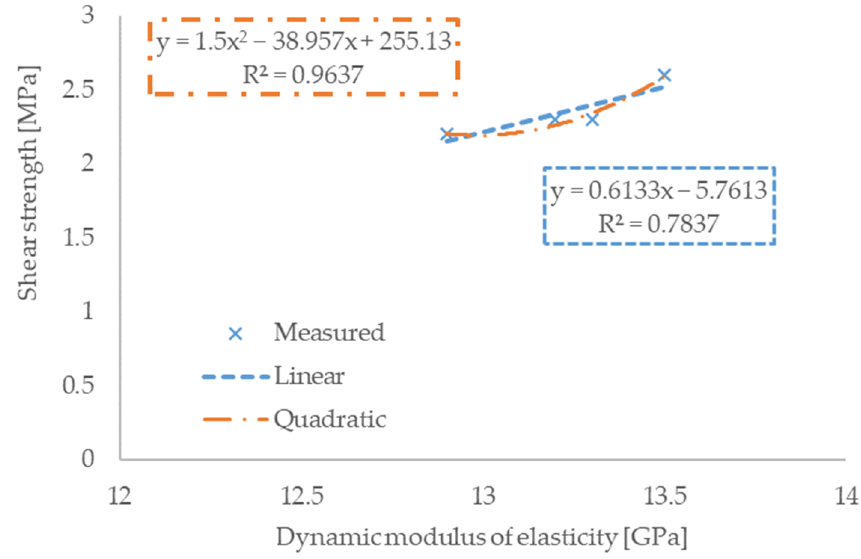
Figure 7. The relationship between dynamic modulus of elasticity and shear strength.